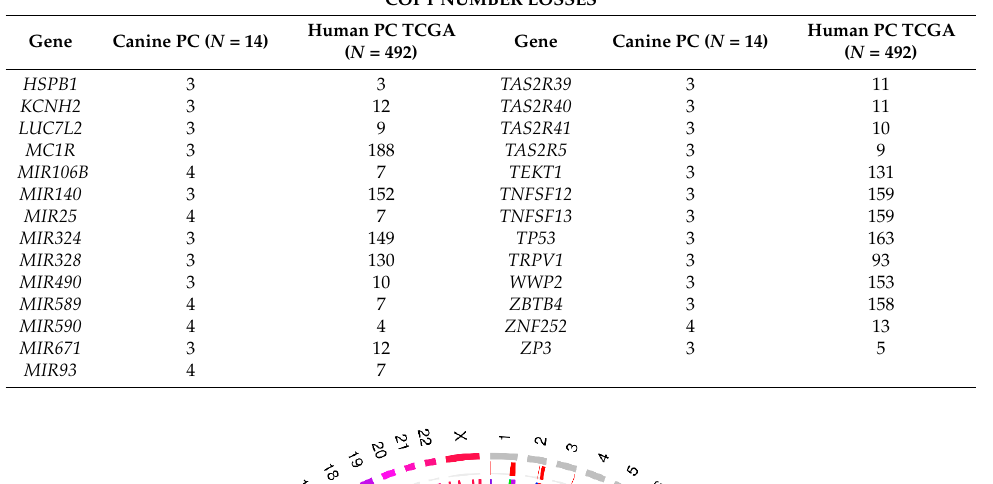
Figure 2. ( A ) Graphic representation of the canonical pathway called the molecular mechanism of cancer. Two cancer-related molecular interaction networks are indicated: ( B ) network 2, and ( C ) network 6, both associated with cell death and survival, organismal injury and abnormalities. Genes involved in gains, and losses are depicted in red and green colors, respectively. Images generated with the Ingenuity Pathway Analysis (IPA) software.